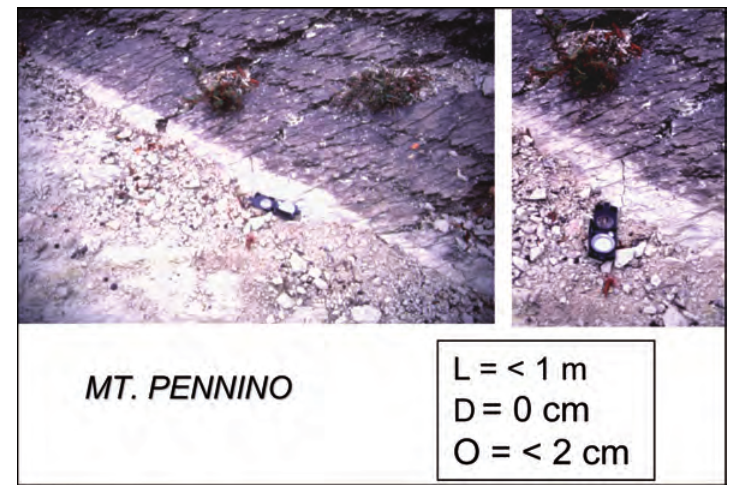
Fig. 7. Few cm long cracks formed transverse to the rock beds of the Pennino Mt. White strip at the base of the dark varnished bedrock is possibly related to sliding of the scree. Detail to the right (compass lies parallel to crack; photos by P. Montone). Symbols: L = Length, D = Displacement; O =